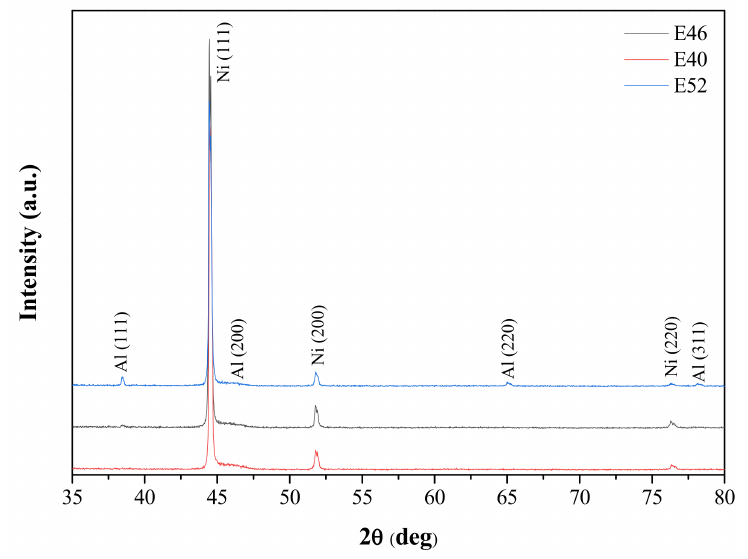
Figure 6. XRD patterns of Al coatings deposited under different potentials on Ni substrates. See Table 1 for sample identification.